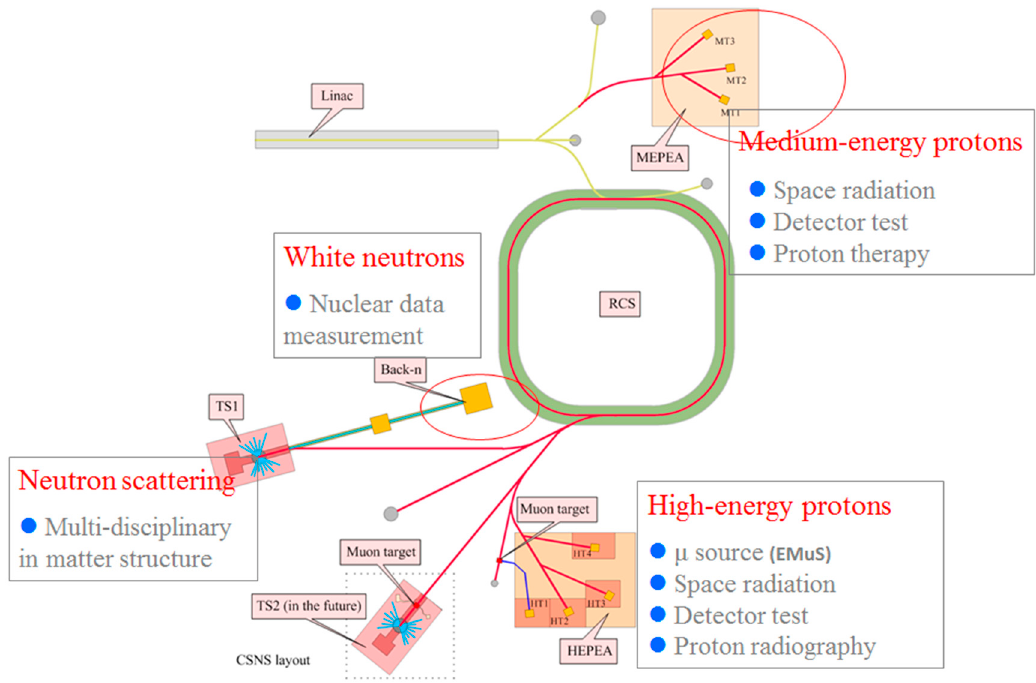
Figure 1. Schematic for multiple application platforms at China Spallation Neutron Source (CSNS).